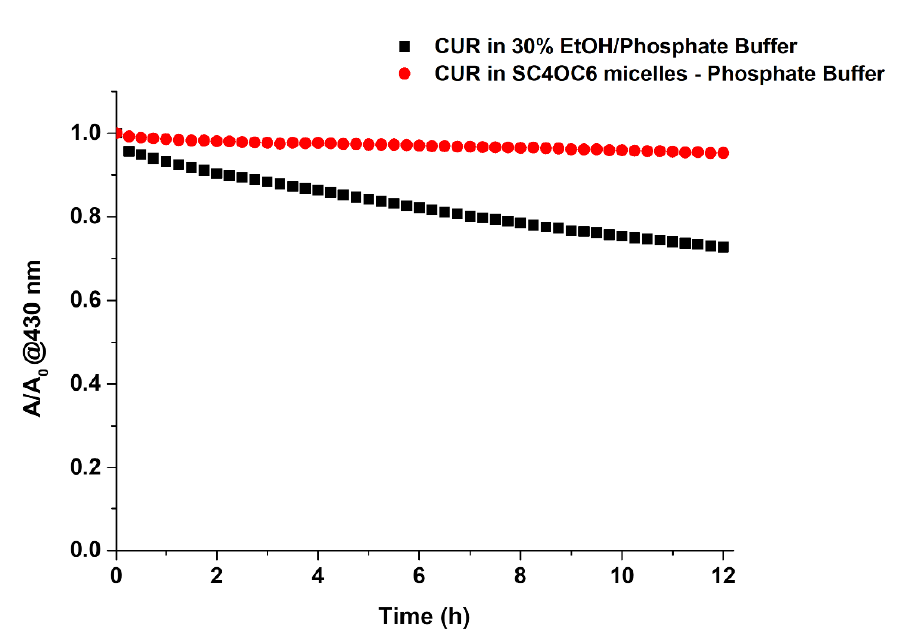
Figure 4. Absorbance values of CUR (λ 430 nm) recorded over time at 37 °C and neutral pH: CUR alone in 30% ethanol/phosphate buffer (0.014 mM, black squares) and CUR (0.014 mM) in SC4OC6 (0.11 mM) nanoparticle in phosphate buffer (red circles).